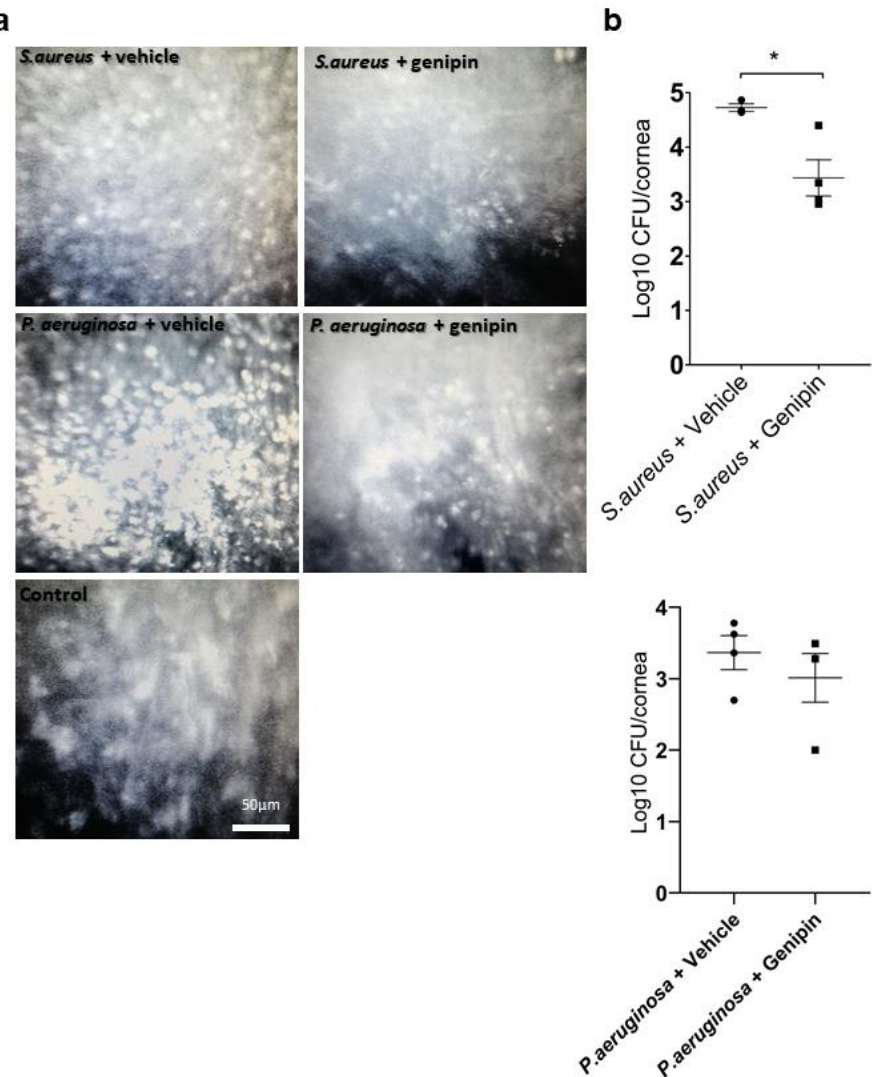
Figure 2. Genipin decreases bacterial growth in the S. aureus keratitis model. ( a ) Confocal microscopy images of the corneal stroma of infected corneas with S. aureus and P. aeruginosa treated with either vehicle solution or genipin at 48 h post-treatment. Genipin treatment demonstrated visible difference in the number of bacterial and inflammatory cells infiltration in the corneal stroma. No infiltrates were observed in the control corneas. Scale bar = 50 µ m ( b ) The number of viable bacterial colonies in the infected corneas, examined by colony-forming unit (CFU) analysis, was expressed as log and plotted for each treatment group ( n = 4 for each experimental group). Error bars represent standard deviation. * Statistically significant ( p <